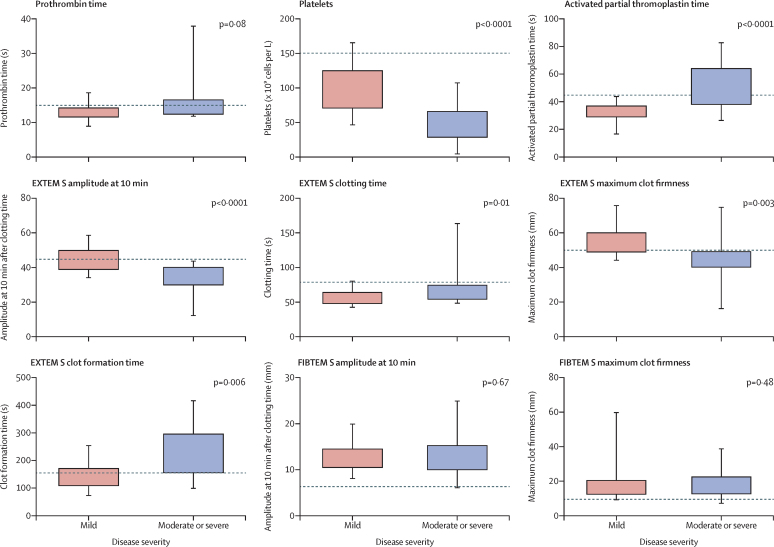
Haematological, coagulation, and rotational thromboelastometry (ROTEM) findings at admission in 45 patients with Crimean–Congo haemorrhagic fever disease, stratified by severityBoxes represent median, 25th, and 75th centiles. Whiskers represent maximum and minimum values. Dotted lines represent limits of normal ranges. EXTEM S=extrinsically activated ROTEM. FIBTEM S=fibrin-specific ROTEM.